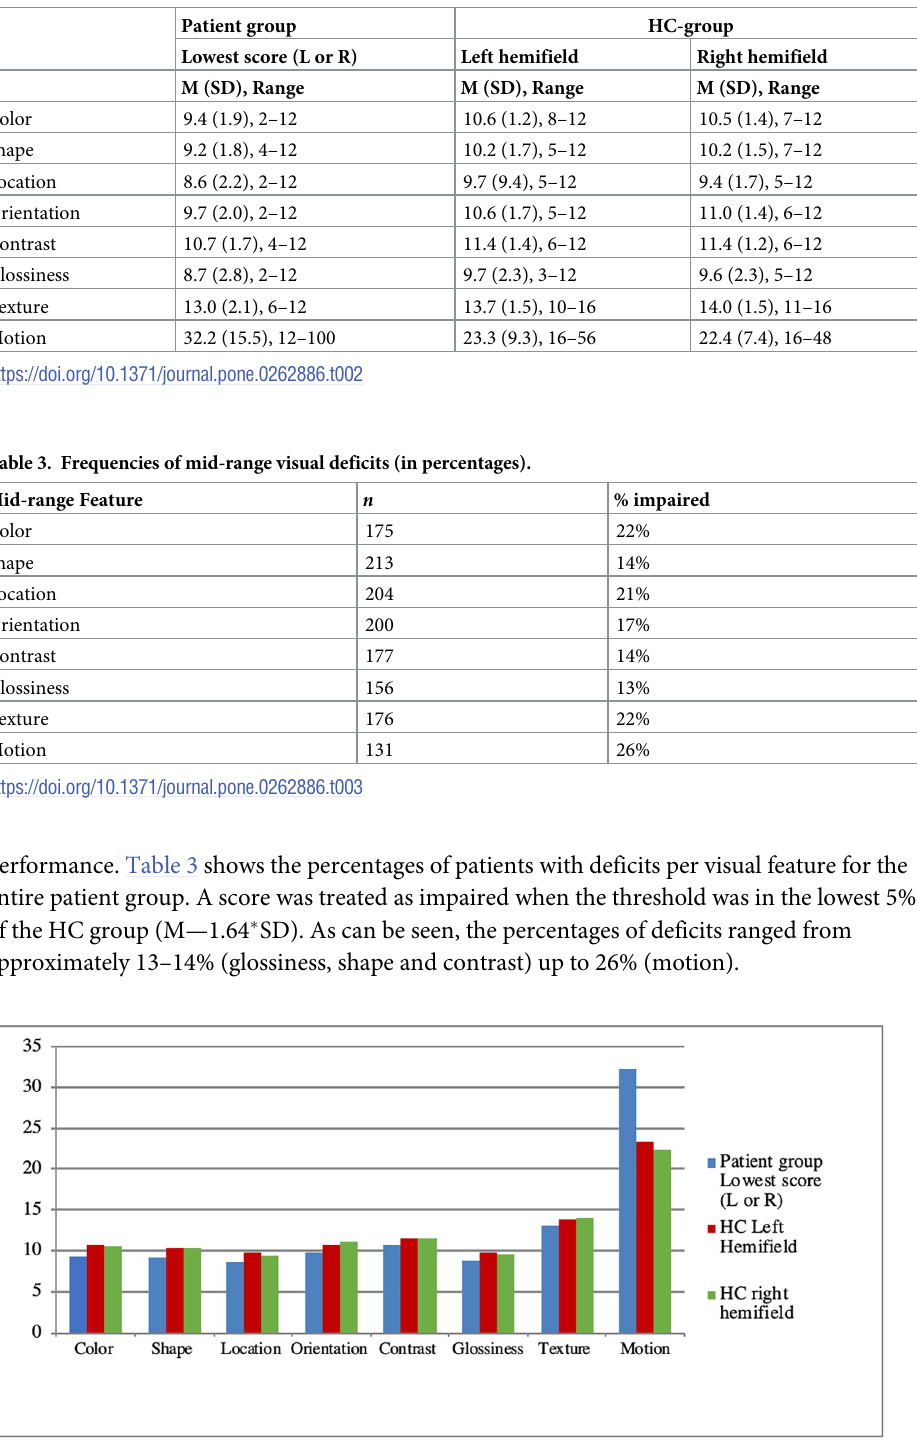
Table 2. Means (M), Standard deviations (SD’s) and ranges of scores of the patient group and the HC-group.